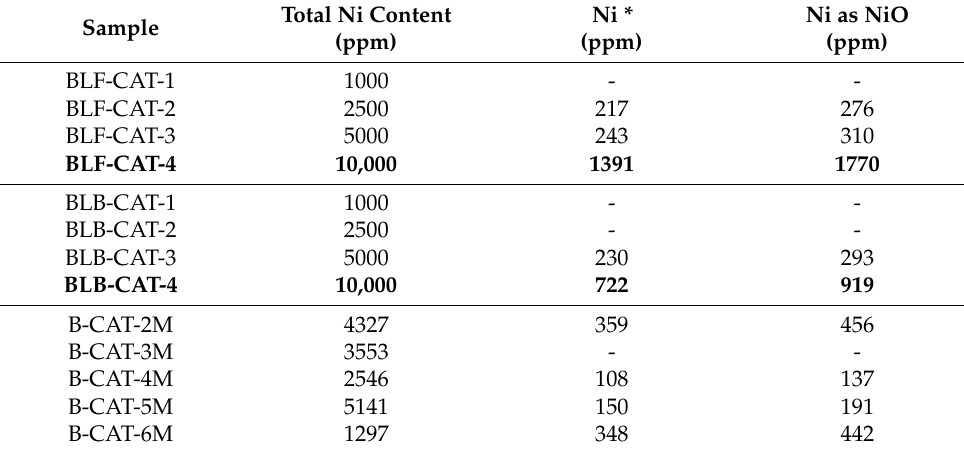
Table 2. Portion of Ni existing as NiO in the Ni-loaded FCC